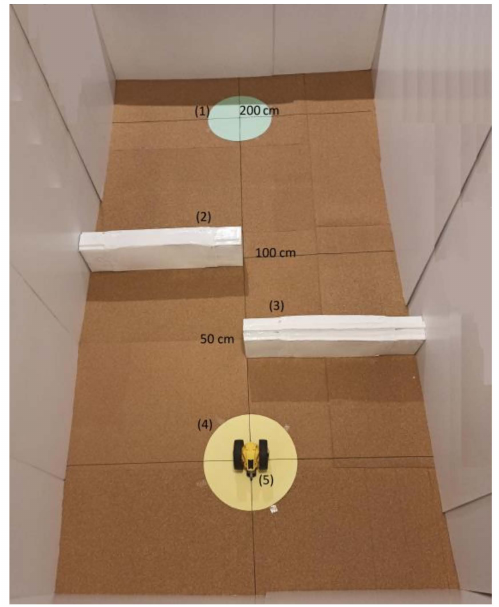
Figure 17. Maze with two obstacles: (1) goal, (2,3) obstacles, (4) home, and (5) robot. After 300 generations, the best motion proposal obtained is simulated; it describes the trajectory shown in Figure